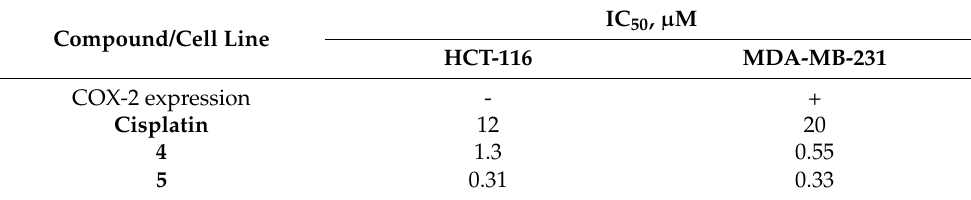
Table 4. Antiproliferative activity of oxaliplatin-based platinum(IV) prodrugs 4 and 5 and cisplatin on HCT-116 (colorectal carcinoma) and MDA-MB-231 (triple negative breast adenocarcinoma) cell lines. The ability of cells to express cyclooxygenase-2 (COX-2) is indicated by “ − ” (non-expressing), “+” (expressing).